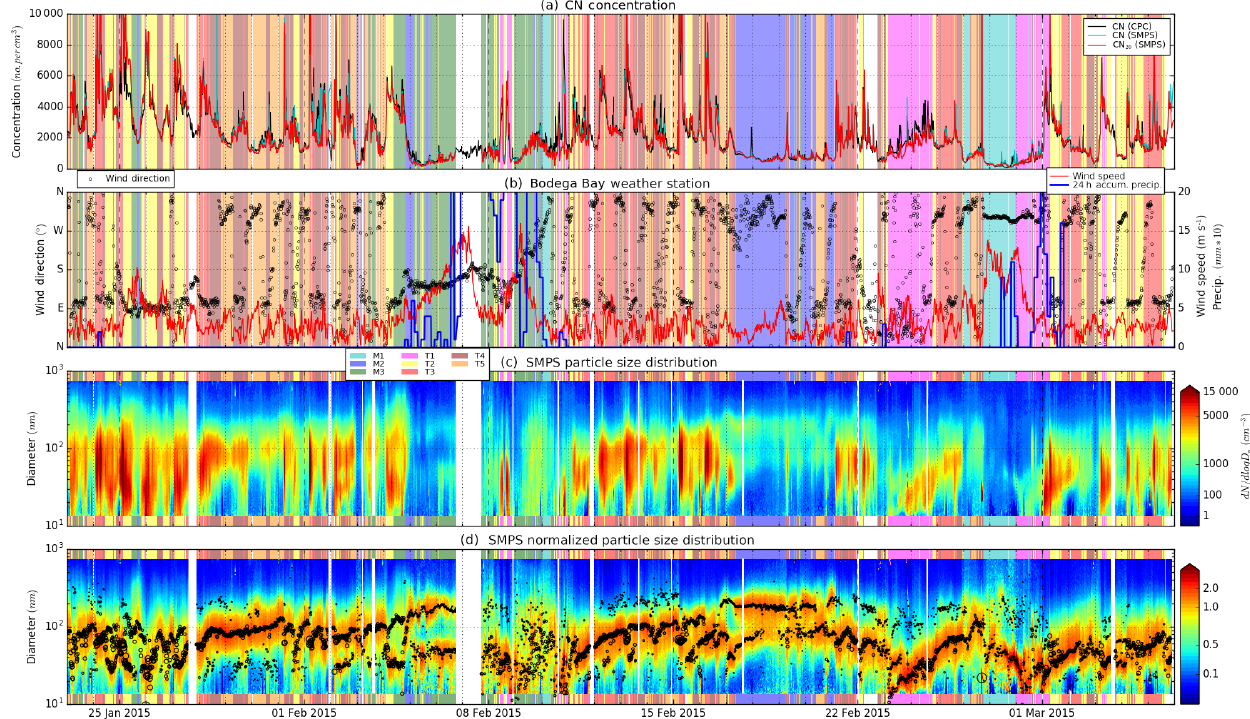
Figure 3. Timelines of study data; all times shown are UTC. (a) Total particle number concentration at BML measured by the CPC (black), reconstructed from SMPS size distributions (blue), and after correction for removal of local sources (red). (b) BML weather station mea- surements of wind direction (black circles) and wind speed (red lines), with HYSPLIT 24h accumulated precipitation along the air mass trajectory (blue). (c) SMPS size distribution as d N/ dlog 10 D p and (d) normalized size distributions with best fit median diameters (black circles) with the size of the circle proportional to the number of particles in the mode. Colored backgrounds in each panel are shown for time periods classified as each cluster type for the 8-cluster K -means